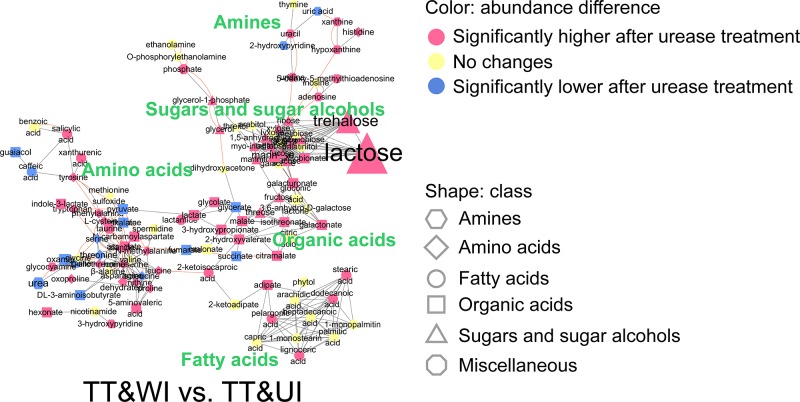
MetaMapp analysis of the effects of urease itself on the profiles of 113 metabolites identified in thermally treated pooled urinary metabolome samples.Group TT&WI: thermally treated, incubated with water without urease, and extracted with pure methanol; group TT&UI: thermally treated, incubated with urease, and extracted with pure methanol. Classes of metabolites are represented by shapes. Significant increases and decreases in the abundance of metabolites after incubation with urease are illustrated by colors (p < 0.05, based on the Mann–Whitney U test with FDR adjusted via the Benjamini–Hochberg correction). Magnitudes of fold changes are represented by the sizes of symbols and labels; biochemical and structural similarities are represented by orange and gray edges, respectively.